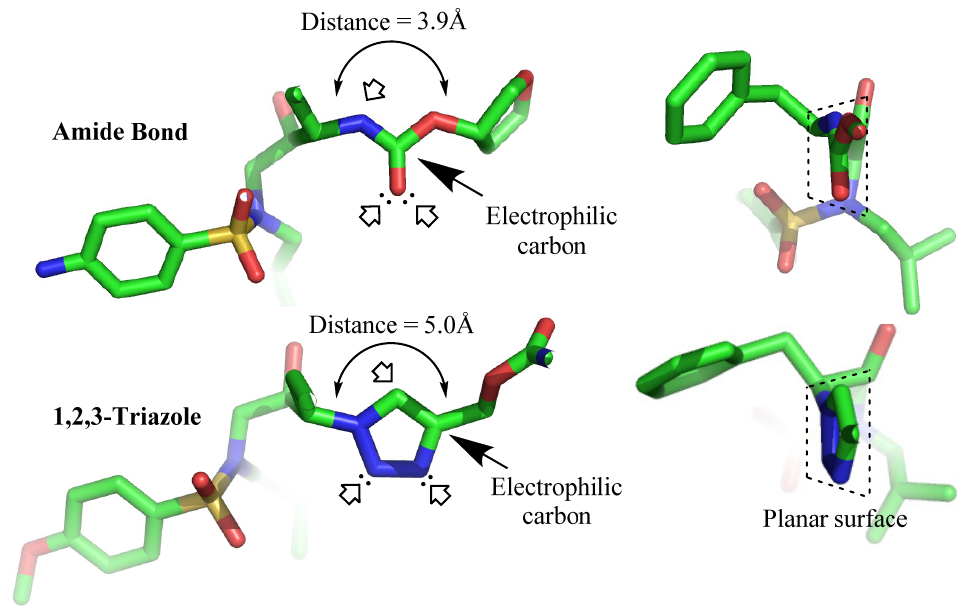
Figure 2. Triazole as amide bond bioisosters. Arrow ( ) represent hydrogen bonding sites. (PDB: 1HPV [59] and 1ZP8